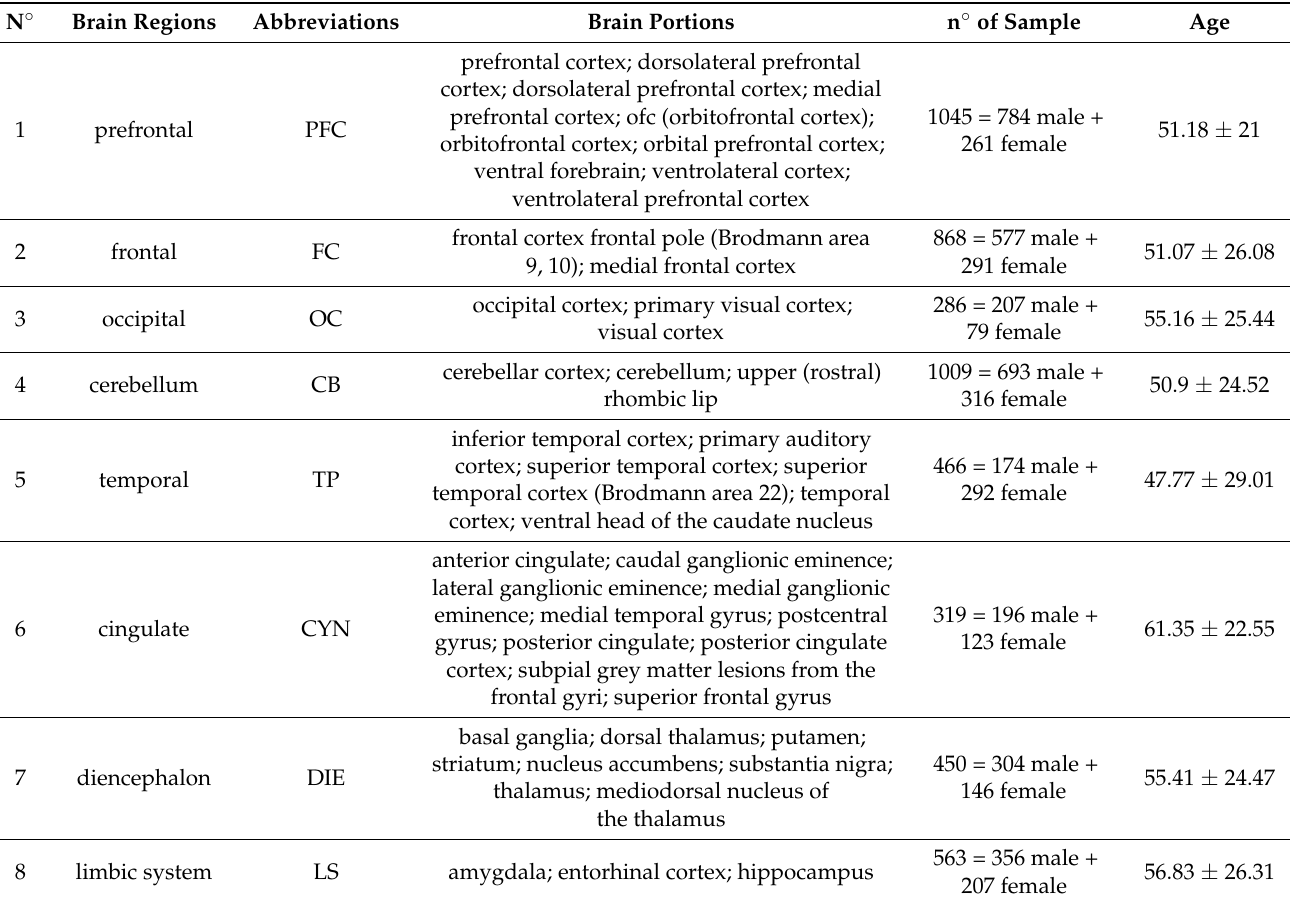
Table 3. Brain regions